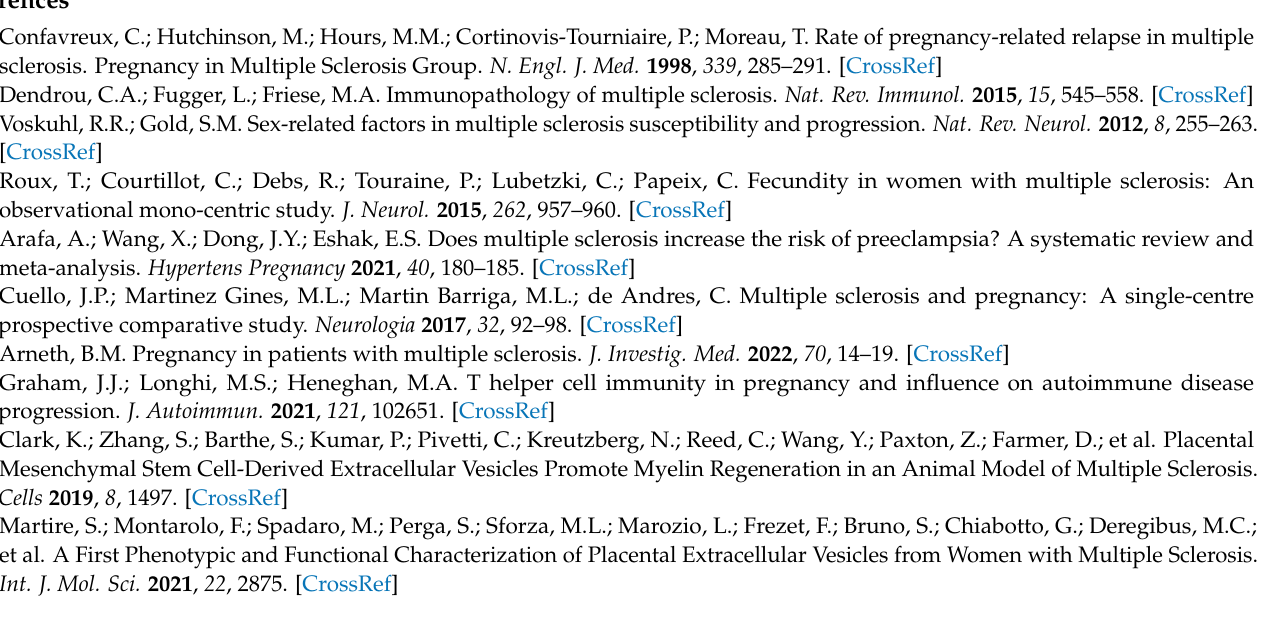
munolocalization; Figure S2: Expression of Homodimeric OPG form. Figure S3: ELISA in SPN before and after OPG